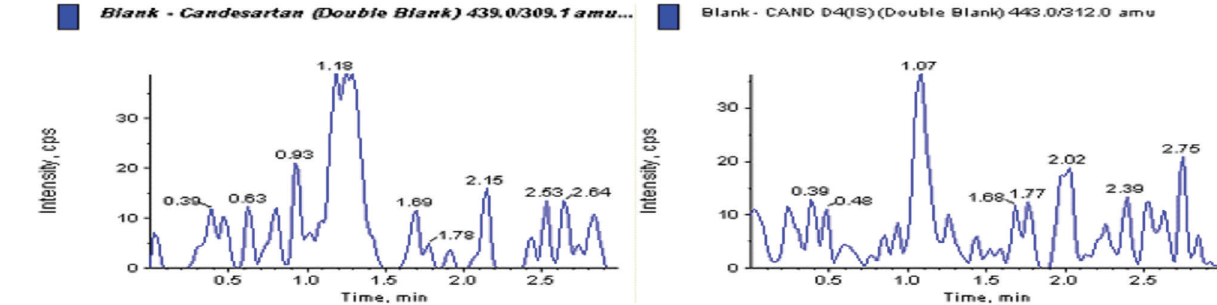
FIGURE 3 - Representative chromatogram of blank plasma